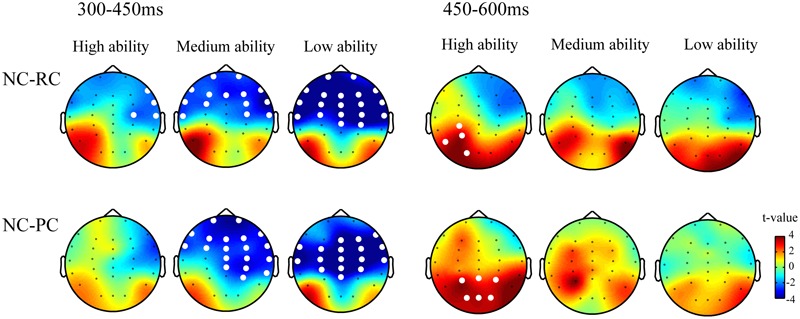
Topographic maps for NC-RC and NC-PC contrasts in the early (300–450 ms) and late (450–600 ms) time windows. White dots represent the electrodes that showed significant differences for the contrast.